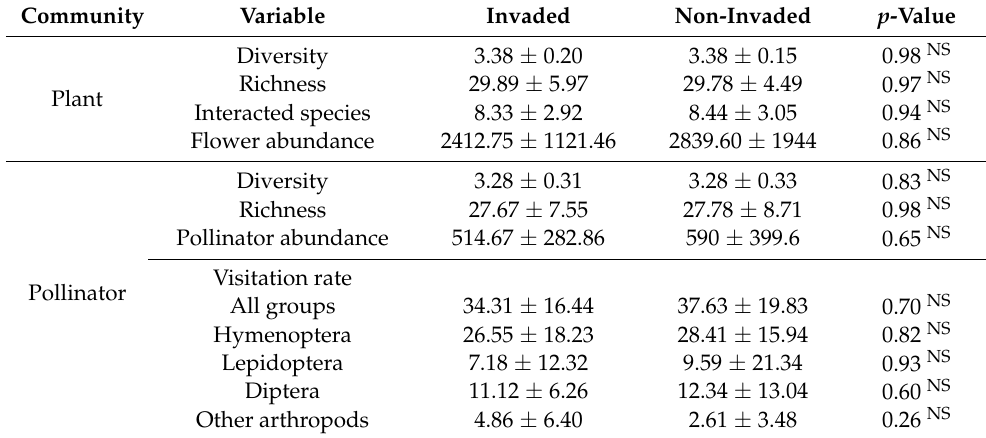
Table 1. Mean ± SD value of plant and pollinator community parameters. To assess differences in plant diversity, plant richness (all species in the plot), plant interacting species, pollinator richness, pollinator abundance, and visitation rate between study systems, we used an independent t -test. For the differences in flower abundance and pollinator diversity between invasion states, we employed Wilcoxon rank sum tests. The differences in Hymenopteran visitation rate between study systems was assessed using an independent t -test. The differences in the visitation rate of Lepidoptera, Diptera, and other arthropods between study systems were assessed with Wilcoxon rank sum test. NS p > 0.05. Community Variable Invaded Non-Invaded p -Value Diversity Plant